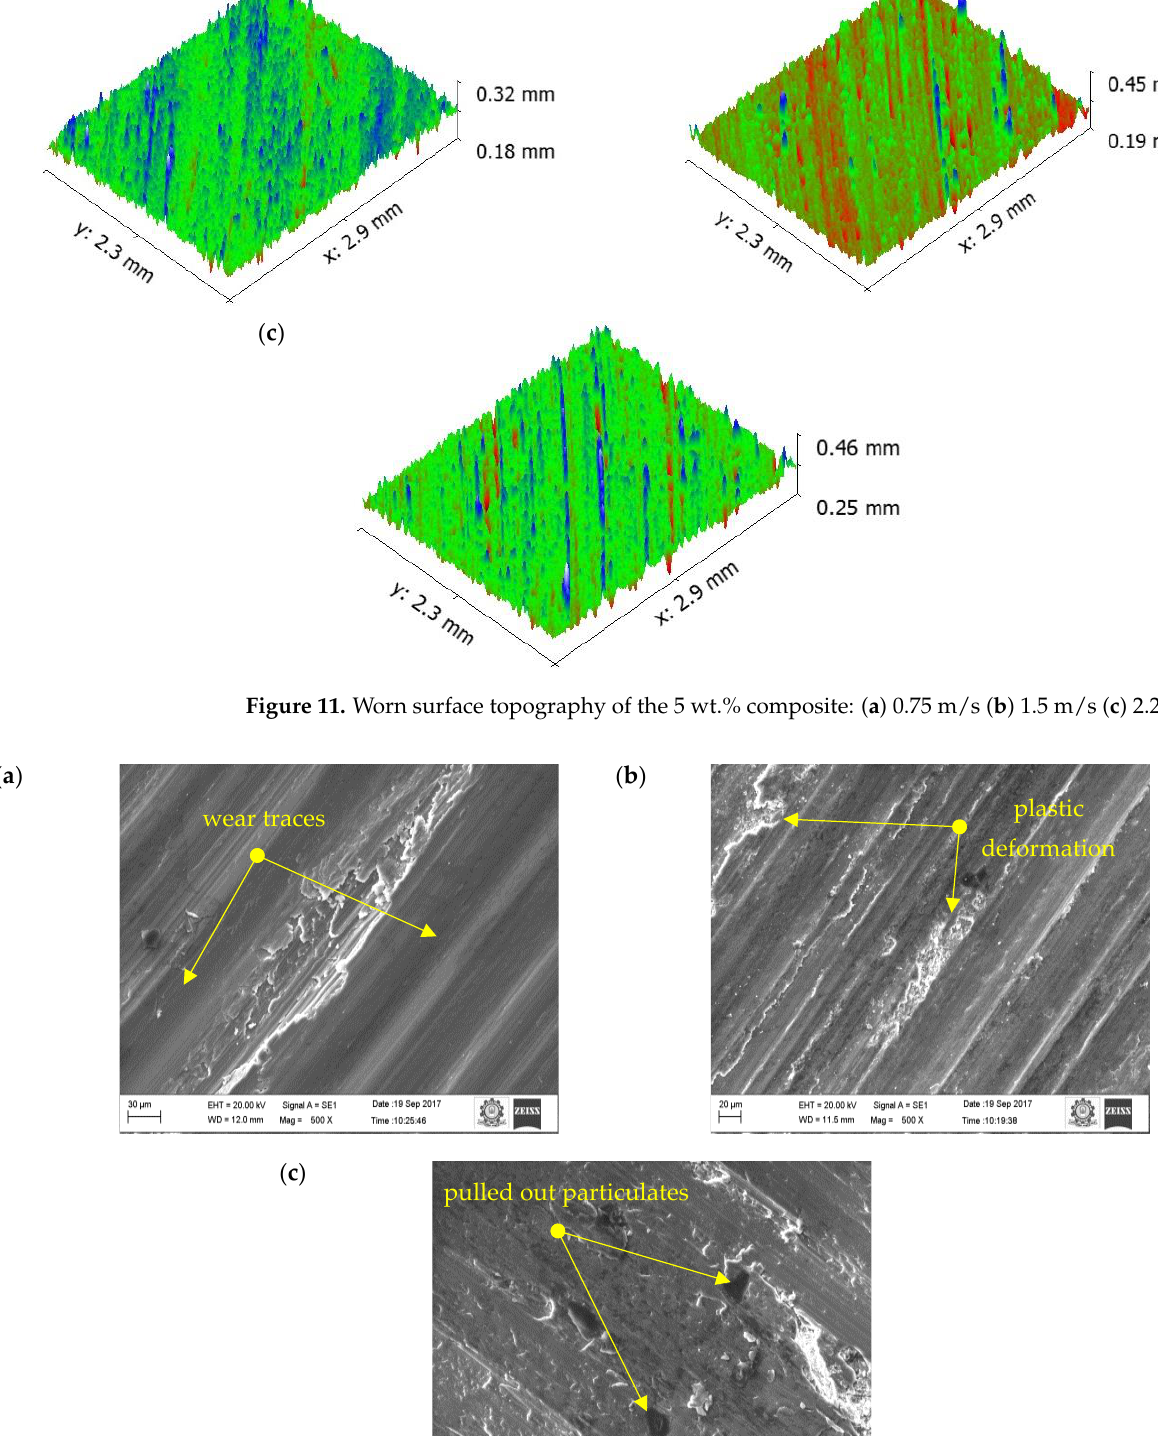
Figure 11. Worn surface topography of the 5 wt.% composite: ( a ) 0.75 m/s ( b ) 1.5 m/s ( c ) 2.25 m/s.